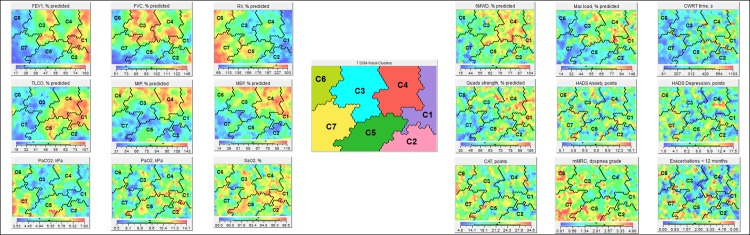
The lung function clusters and the related functional and health status characteristics.The seven lung function clusters in chronic obstructive pulmonary disease (COPD) and the related functional and health status characteristics. When looking at the different lung function, functional characteristics and health status, subjects “raise a red flag” if the attribute is relatively high within this sample, present “a green flag” if the clinical attribute is moderate, and present “a blue flag” when the clinical attribute is relatively low within this sample. In this way the maps can be interpreted. The Viscovery program placed all subjects on a specific position on the map based on their profile of a comprehensive lung function assessment. The more subjects resemble in terms of their lung function the closer they are on the map. Contrarily, the more they differ the further they are away from each other. By drawing lines on the map, the Viscovery program could identify seven different clusters of patients with COPD with a significant different respiratory physiome (95% confidence interval).